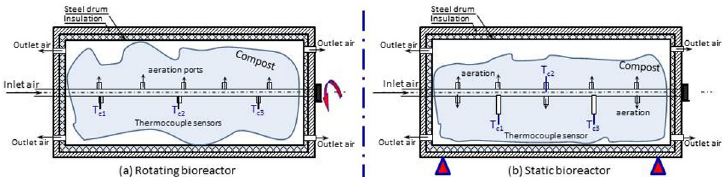
Fig 2. Cross-sectional views of the (a) rotating bioreactor and (b) static bioreactor Showing the inlet and outlet aeration ports and the locations of thermocouple